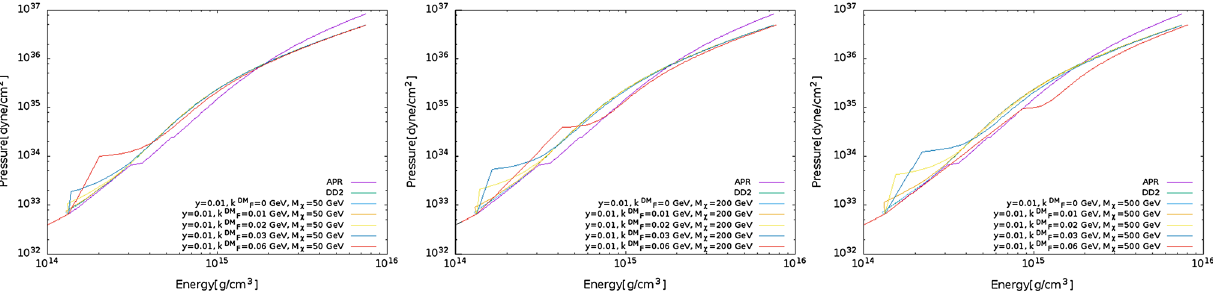
Fig. 1 Pressure vs energy plots for M χ = 50GeV (left panel), M χ = 200GeV (middle panel), M χ = 500GeV (right panel) with varying DM Fermi momenta in each panel